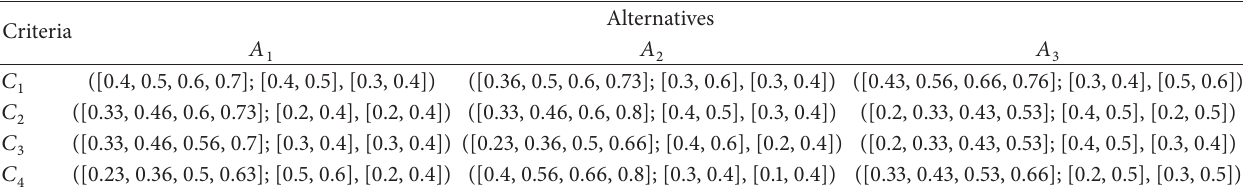
Table 4: Decision matrix 𝐷